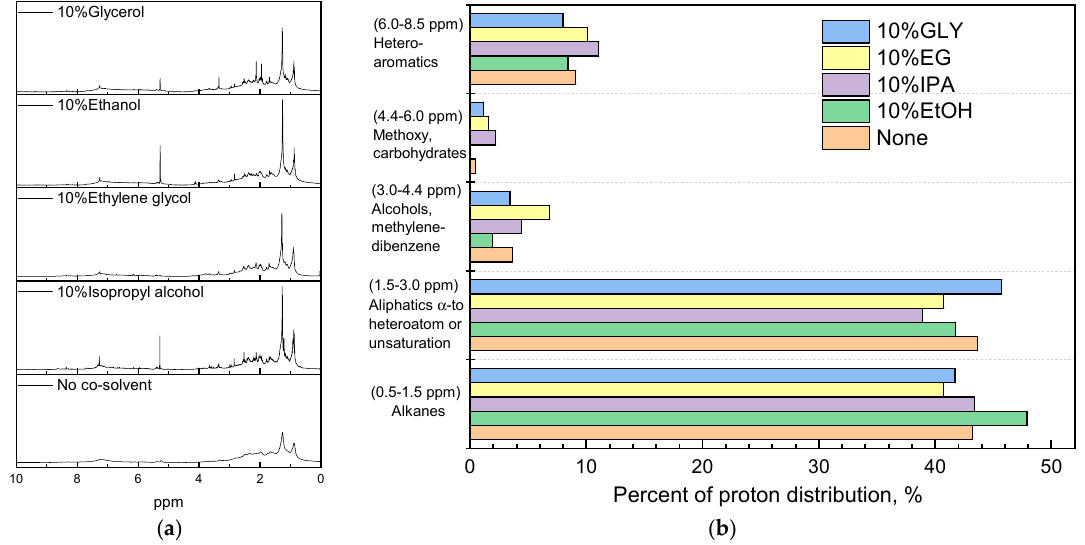
Figure 5. 1 H NMR spectra ( a ) and hydrogen percentage ( b ) of biocrude produced from hydrothermal liquefaction (HTL) treatment of Tetraselmis sp. at 350 °C when including different co-solvents.